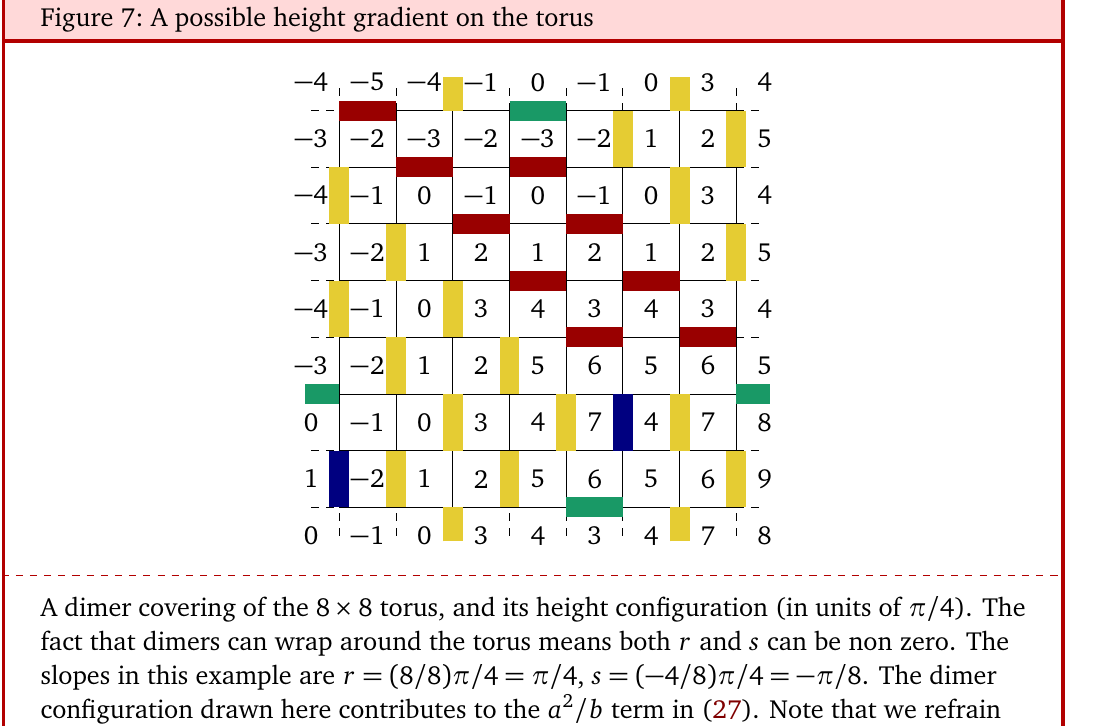
Figure 7: A possible height gradient on the torus